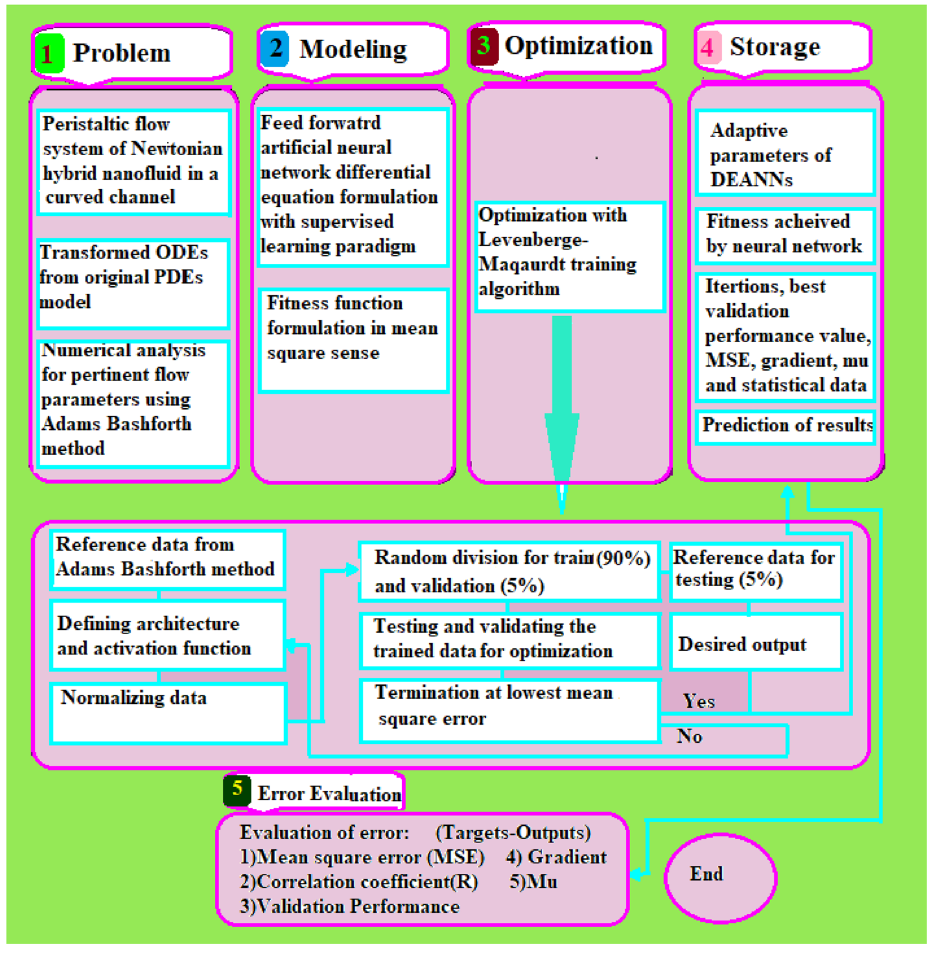
Figure 2. Schematic of proposed